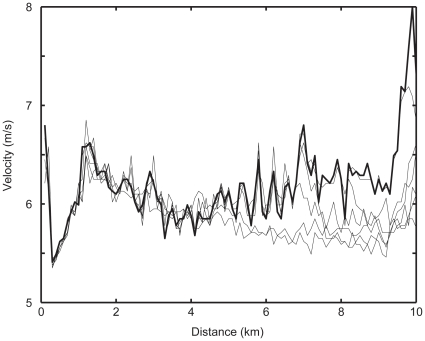
Velocity of the winner (bold) and the runners successively 5 places further back (e.g., 5th, 10th, 15th) from the Beijing Olympic men's 10 km race.